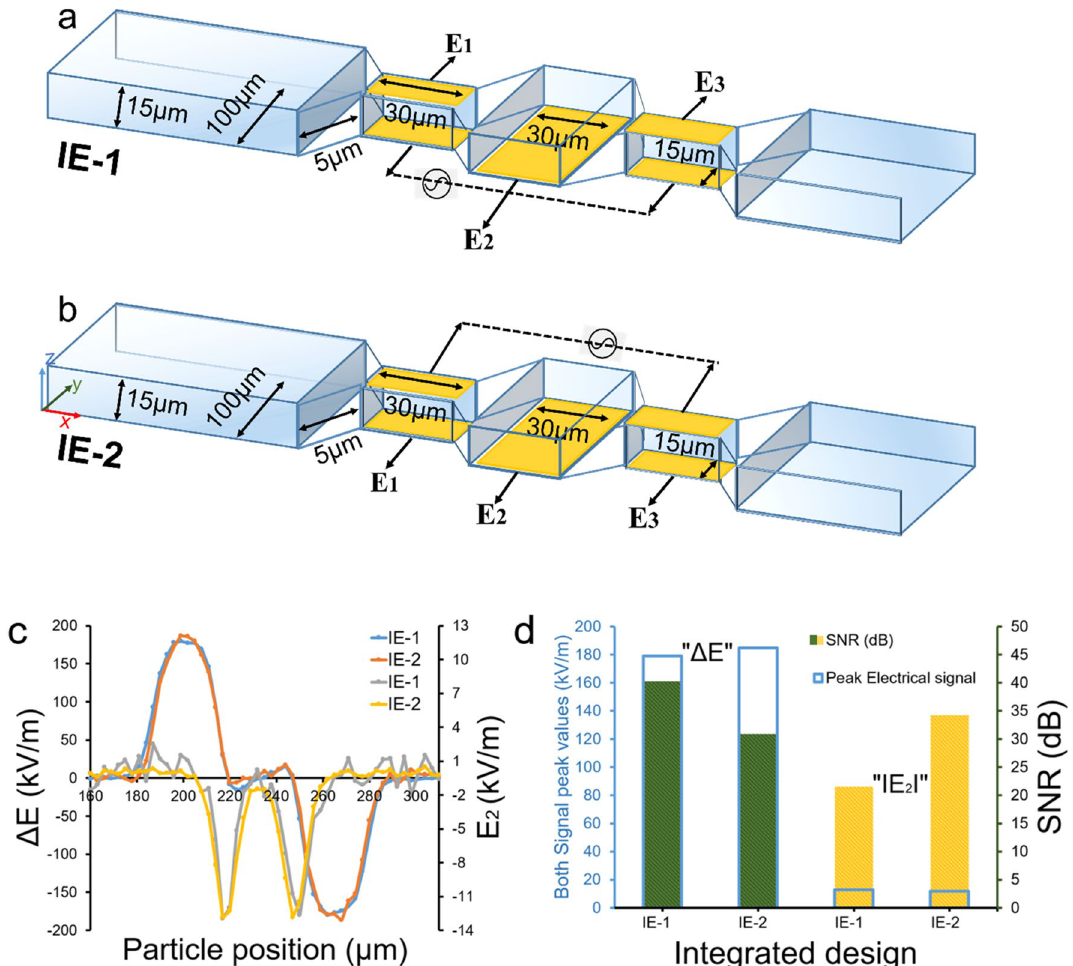
Figure 2. Detailed geometrical dimensions for integrated multi-planar designs of microelectrodes (IE-1 and IE-2) with microfluidic channel in 3-D view, ( a , b ) Integrated electrode designs with input signal and output signals; IE-1 ( a ) and IE-2 ( b ), ( c ) Output signals ΔE = E 1 –E 3 (bipolar pulse) and E 2 (unipolar pulse) from IE-1 and IE-2 relative to the particle position in the channel, ( d ) Comparison between the ΔE = E 1 –E 3 and E 2 signal peak values with respect to SNR in dB for IE-1 and IE-2. Figures ( a , b ) are drawn in Microsoft PowerPoint